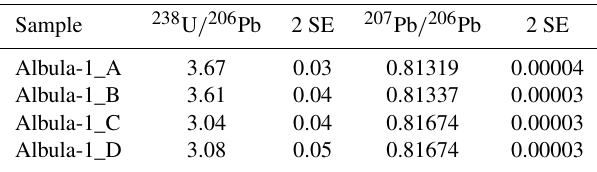
Table 6. 238 U / 206 Pb and 207 Pb / 206 Pb ratios measured by solution ICP-MS. Uncertainties are given as 2 standard errors (2 SE).